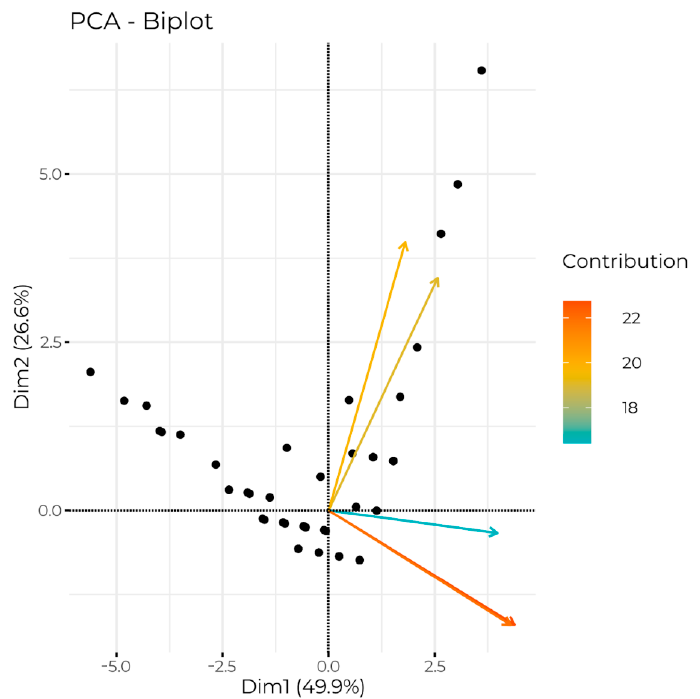
Figure 2. Biplot illustrating the placement of observations and variables on two-dimensional space. Variables (presented as arrows) were filled according to their contribution to the appropriate di- mension. Observations were presented as black dots. The names of subsequent dimensions were accompanied by information about the percentage of explained variance in the output data.